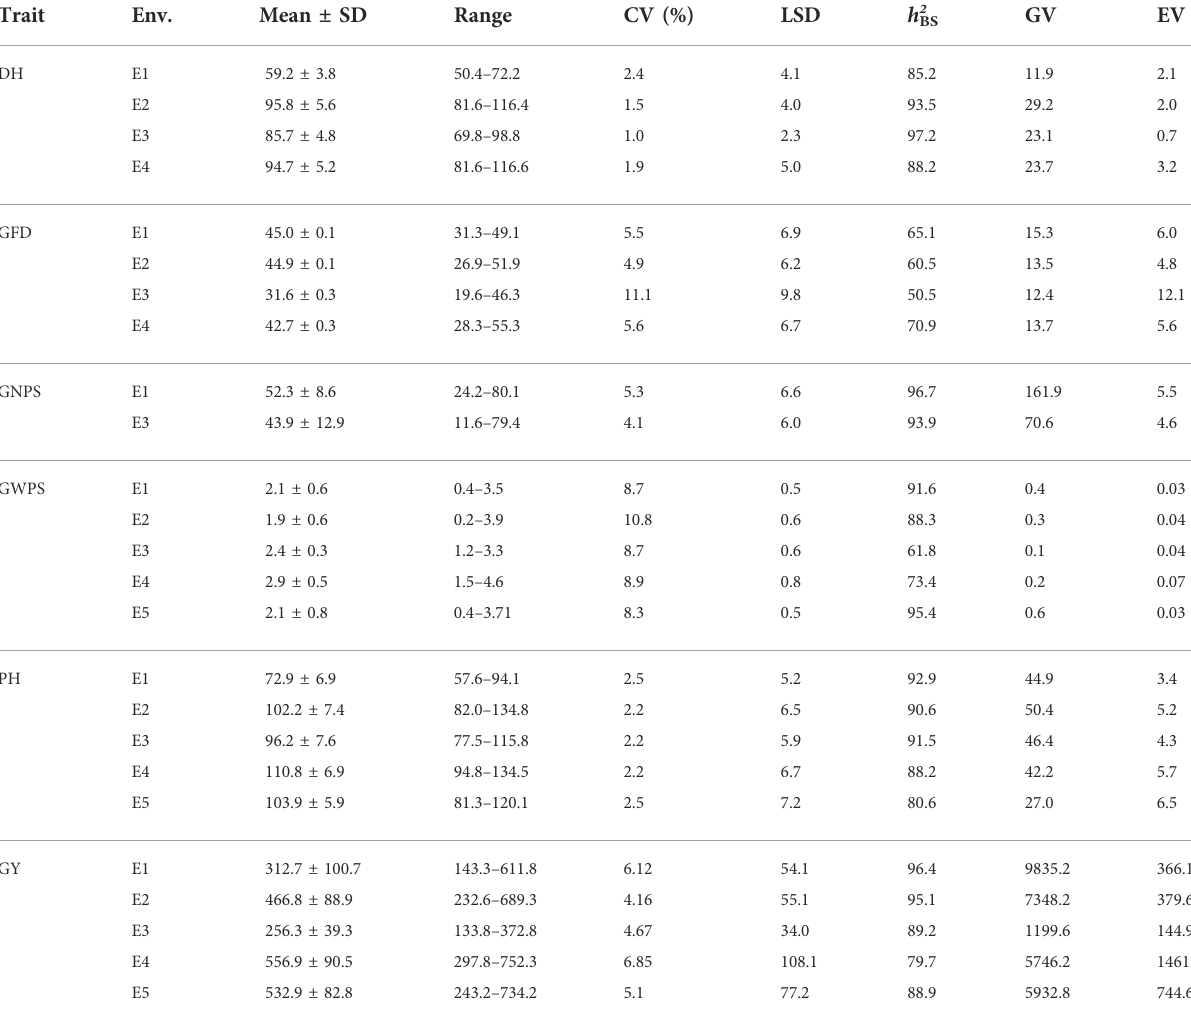
TABLE 1 Descriptive statistics, variance, and heritability estimates of grain yield and component traits in GWAS panel evaluated at Dharwad, IARI Delhi, IARI Jharkhand, Karnal, and Ludhiana during 2020 – 2021. Trait